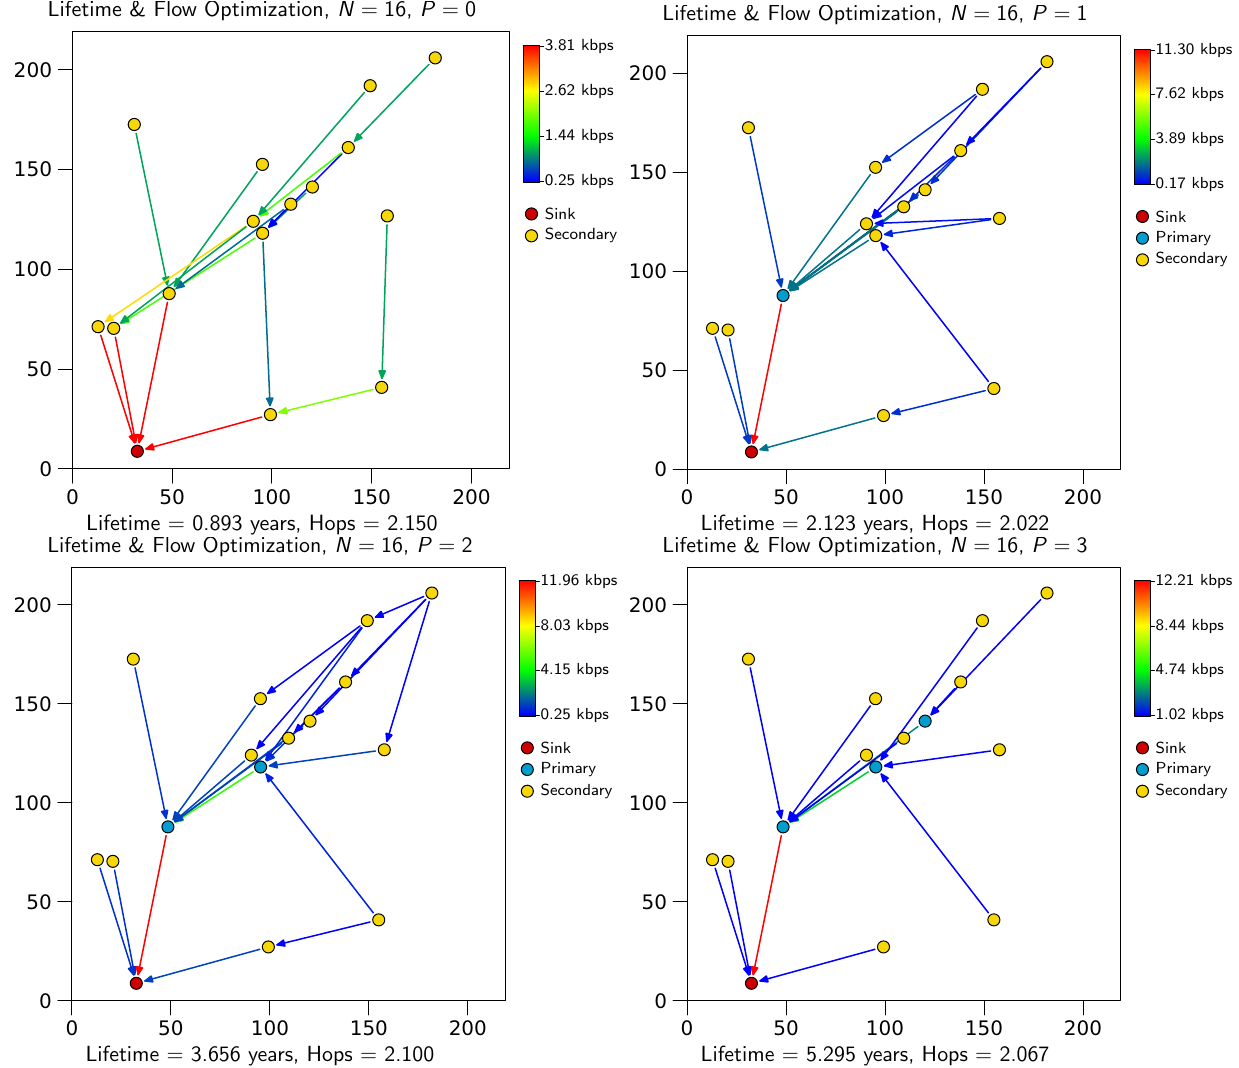
Figure 2. Flow assignment example for a scenario with 16 nodes (the same scenario as in the example of Figure